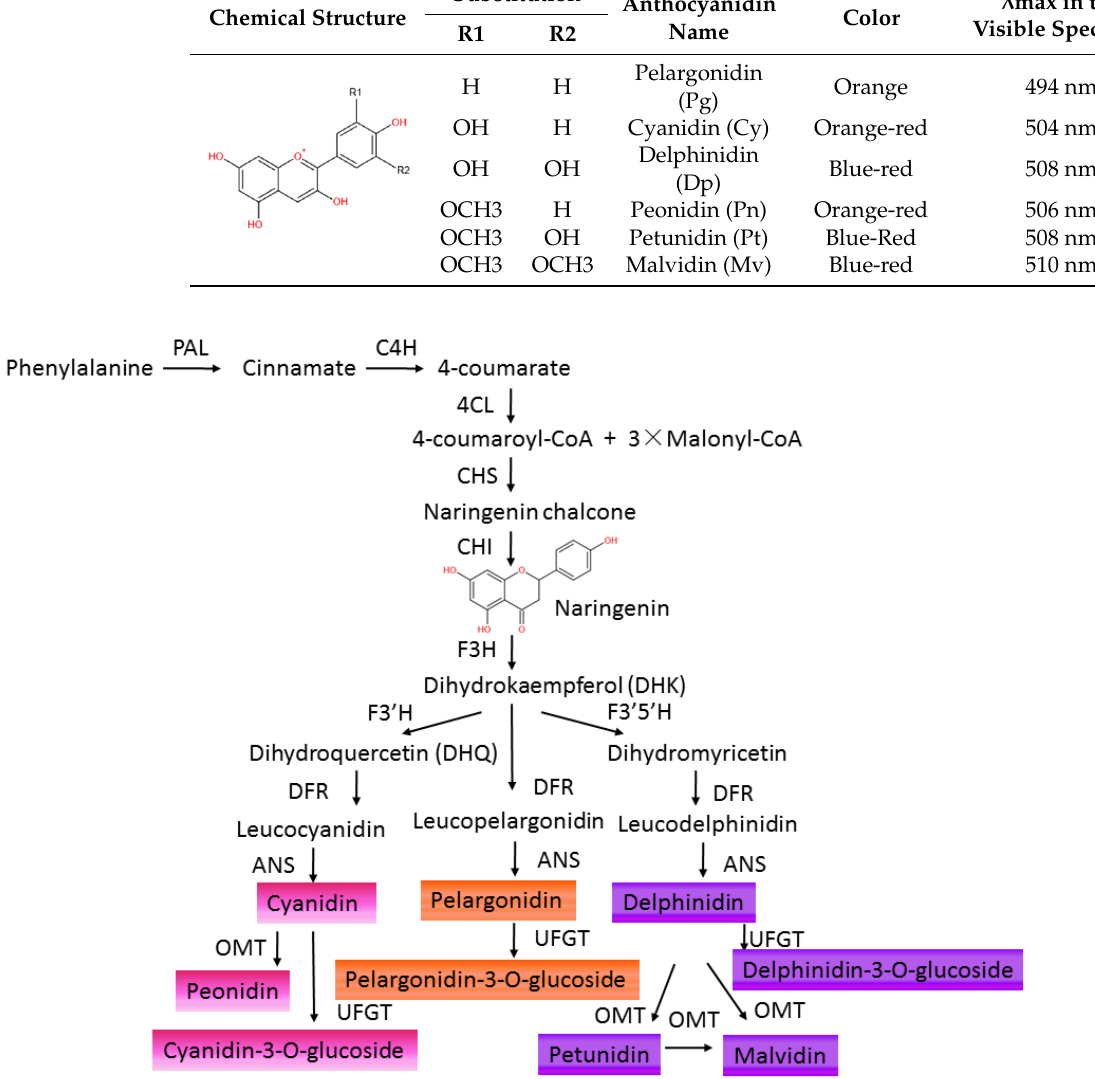
Figure 1. The pathway of anthocyanin biosynthesis. PAL, phenylalanine ammonia lyase; C4H, cinnamate 4-hydroxylase; 4CL, 4-coumarate CoA ligase; CHS, chalcone synthase; CHI, chalcone isomerase; F3H, flavanone 3-hydroxylase; F3 ′ H, flavonoid 30 hydroxylase; F3 ′ 5 ′ H, flavonoid 3050hydroxylase; FLS, flavonol synthase; DFR, dihydroflavonol 4-reductase; ANS, anthocyanidin synthase; UFGT, UDP-galactose flavonoid 3-O-galactosyltransferase; OMT, O-methyl transferase.